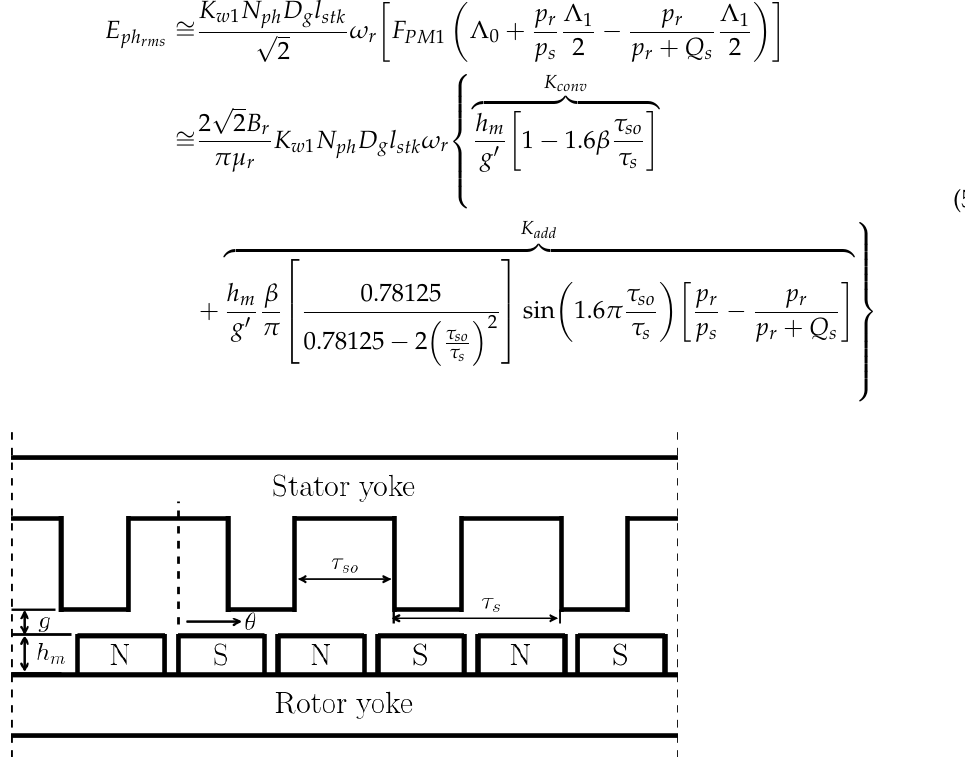
Figure 2. Linearized and simplified typical geometry of a